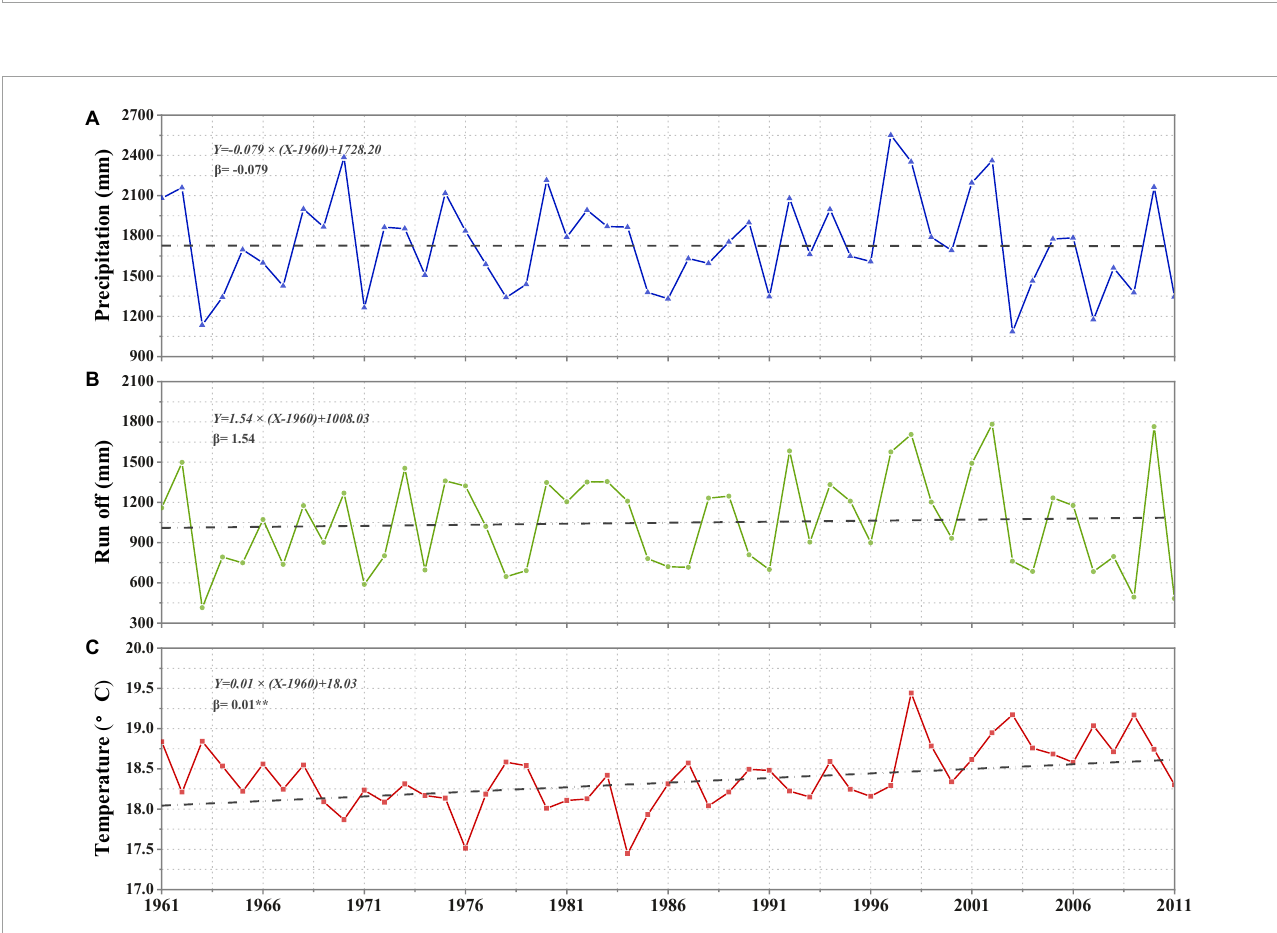
FIGURE5 (A) Precipitation, (B) runoff, and (C) temperature changes throughout time, together with their respective rates of change ( β ). Asterisk (*) and (**) denote significant trends at the P 0.1 and P 0.05 levels, respectively.